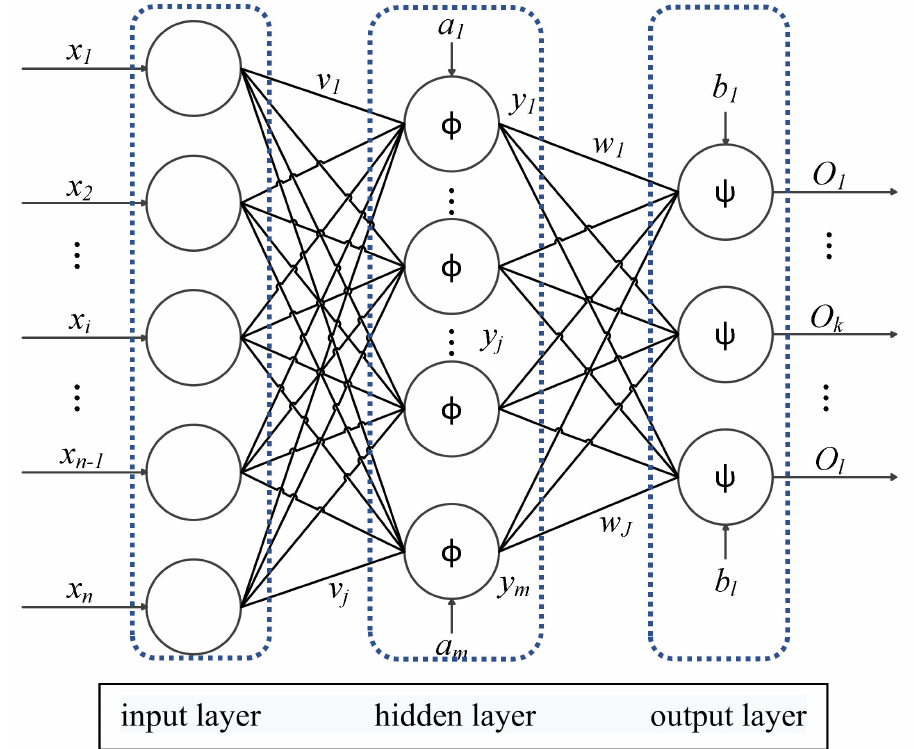
Figure 1. Three-layer BP neural